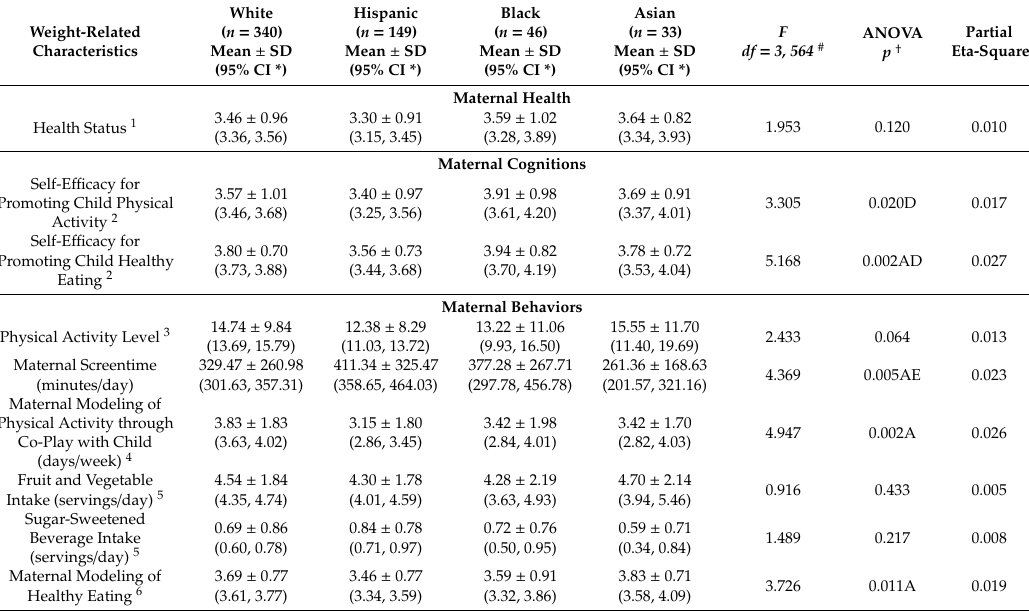
Table 2. Maternal Weight-Related Characteristics by Race / Ethnicity ( N = 568). Weight-Related